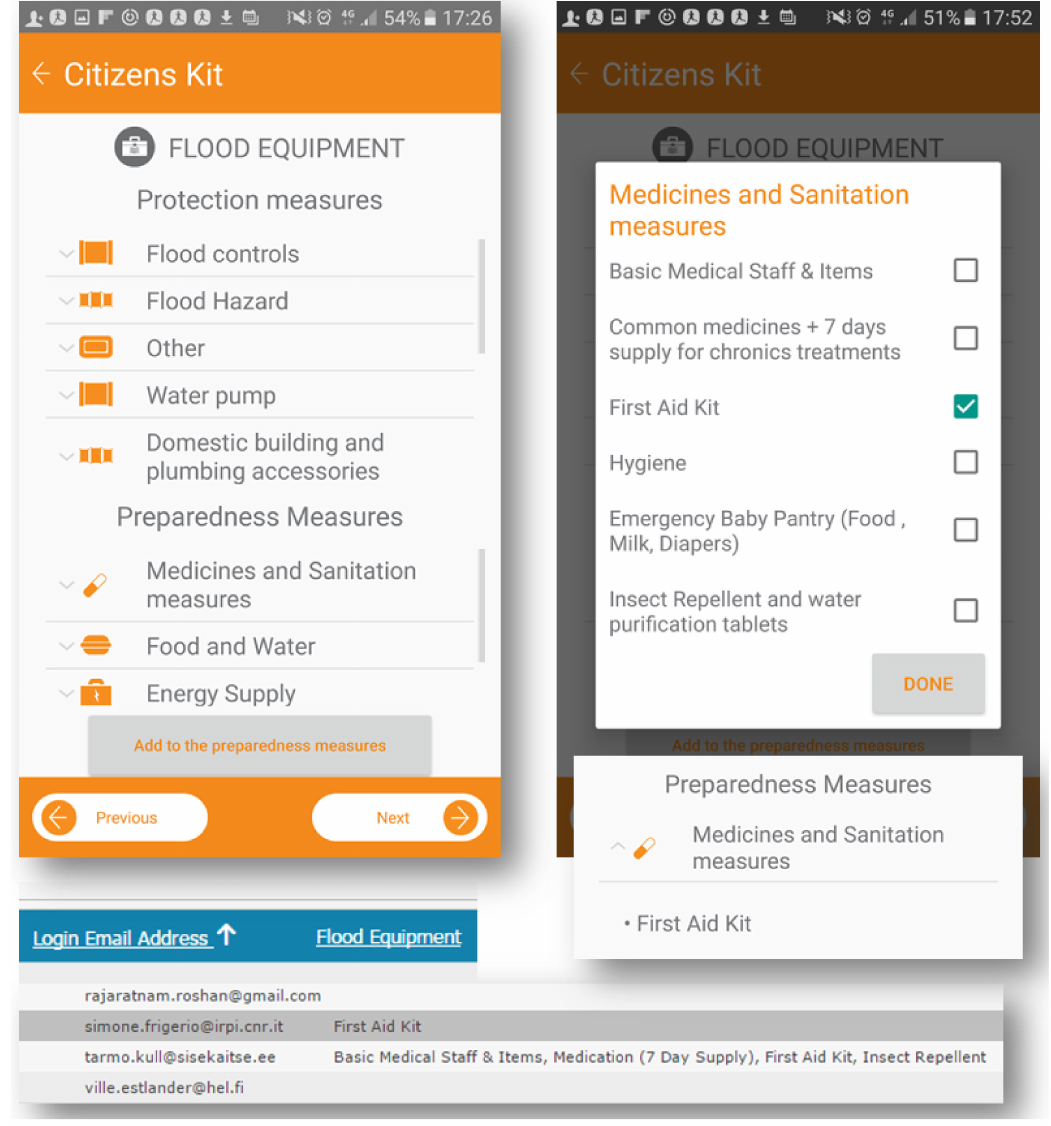
Figure 3. Personal kit built for flood protection and preparedness